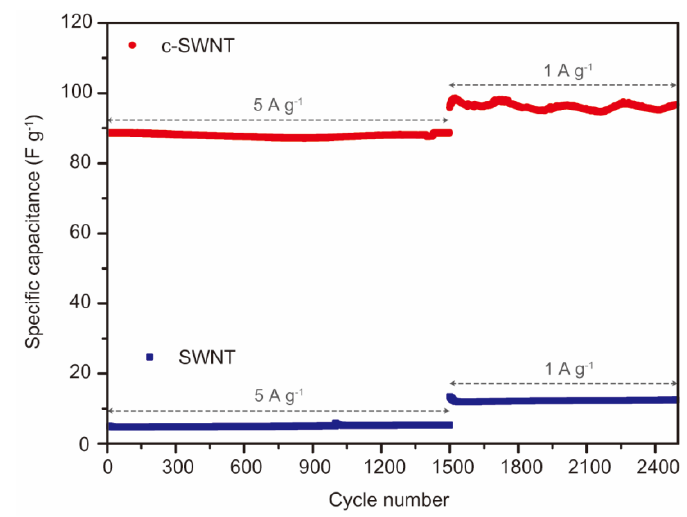
Figure 8. The cycle retention of SWNT (blue) and c-SWNT (red) electrodes at a current density. The first 1500 cycles were performed at 5 A g −1 , followed by an additional 1000 cycles at 1 A g −1 .